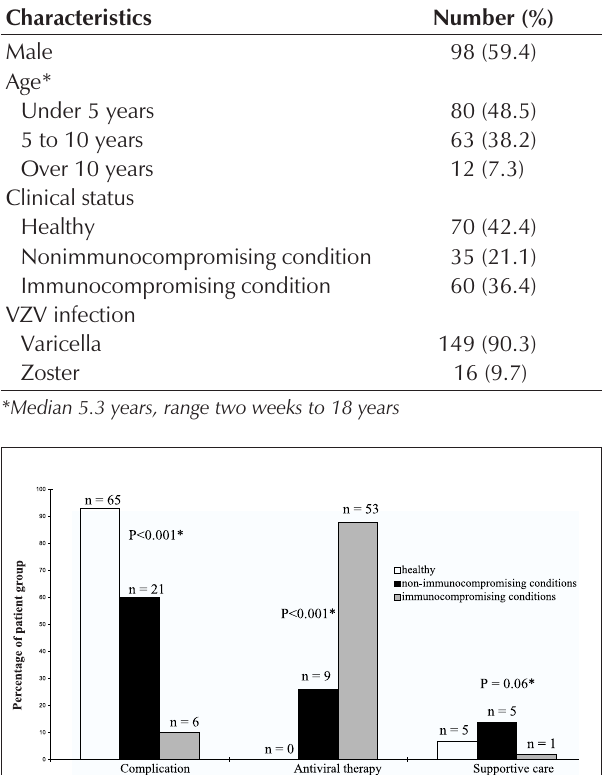
Summary of complications noted on admission in 92 children hospitalized with varicella zoster virus (VZV) infections